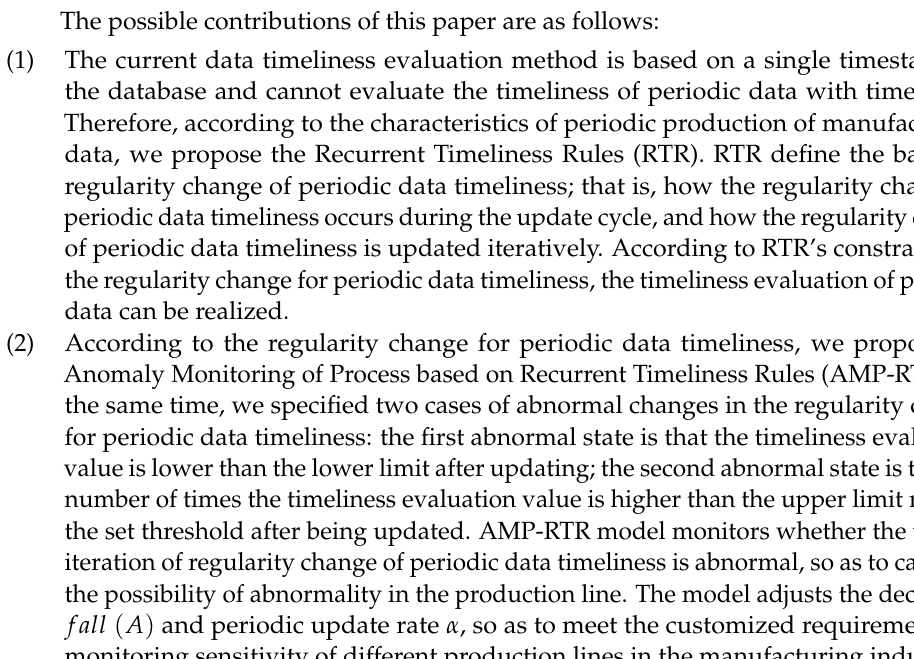
Figure 1. The AMP-RTR research flow diagram.